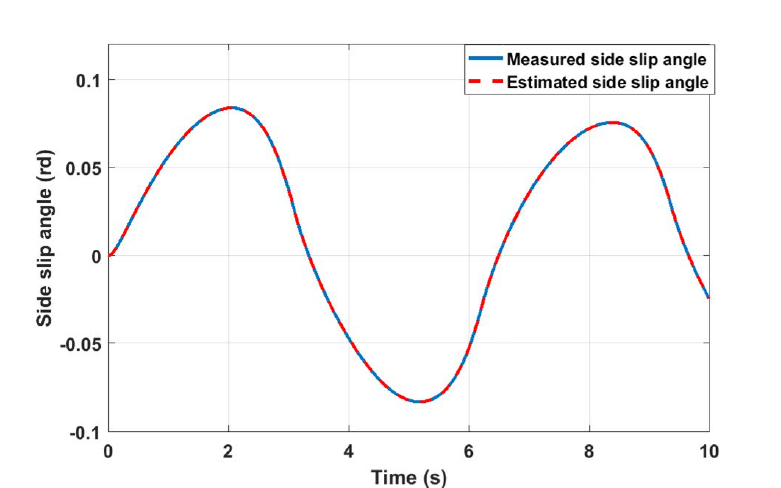
Figure 11. Estimated vehicle sideslip with FTC Strategy.